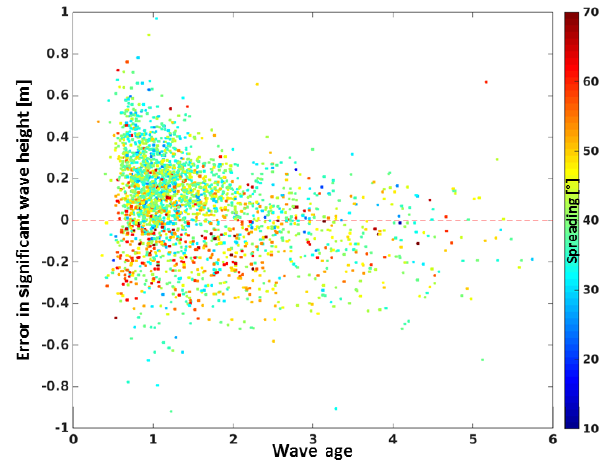
Figure 8. Scatter plot of wave age versus error in significant wave height from comparison of the buoy to the radar ( H s = 4 σ D ). Color coding represents the directional spreading of the wave